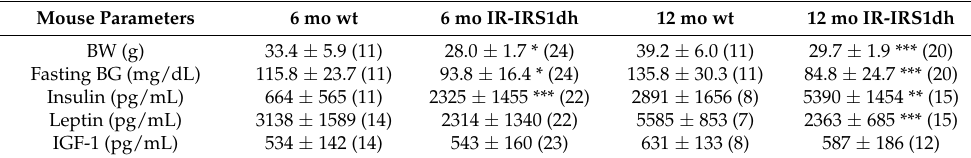
Table 1. Metabolic